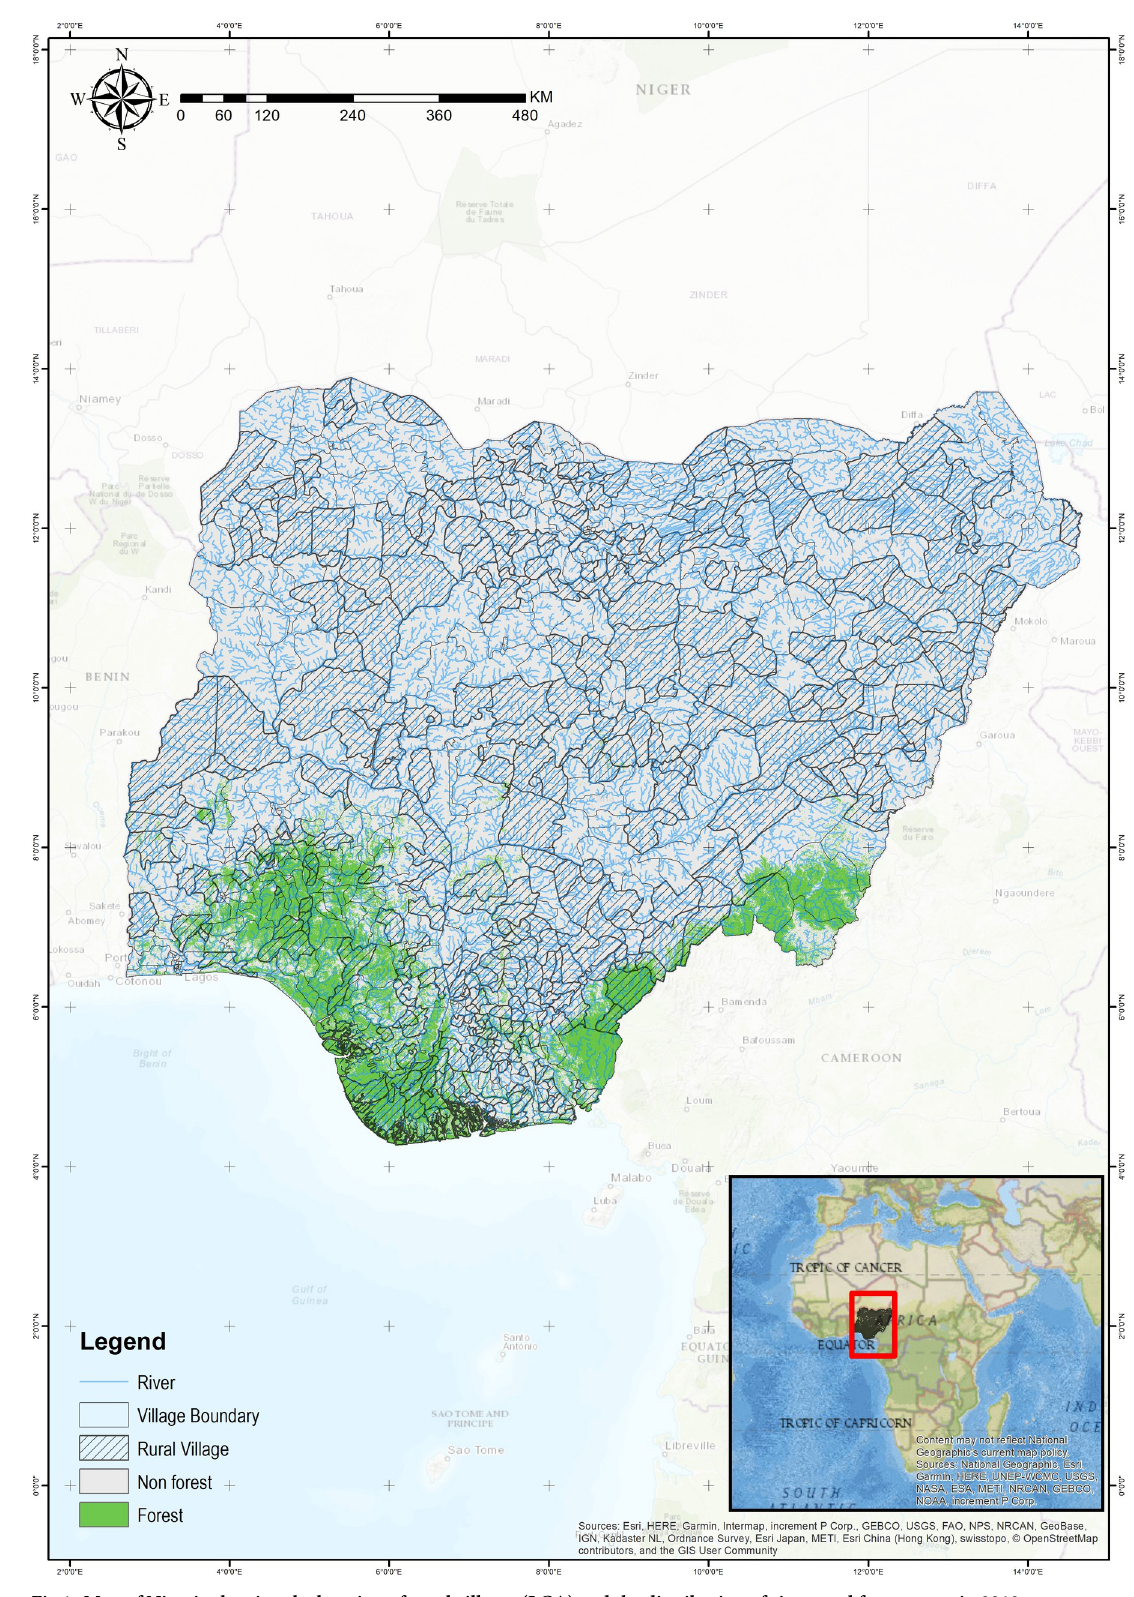
Fig 1. Map of Nigeria showing the location of rural villages (LGA) and the distribution of rivers and forest cover in 2012. https://doi.org/10.1371/journal.pone.0218038.g001 PLOS ONE | https://doi.org/10.1371/journal.pone.0218038 June 11,